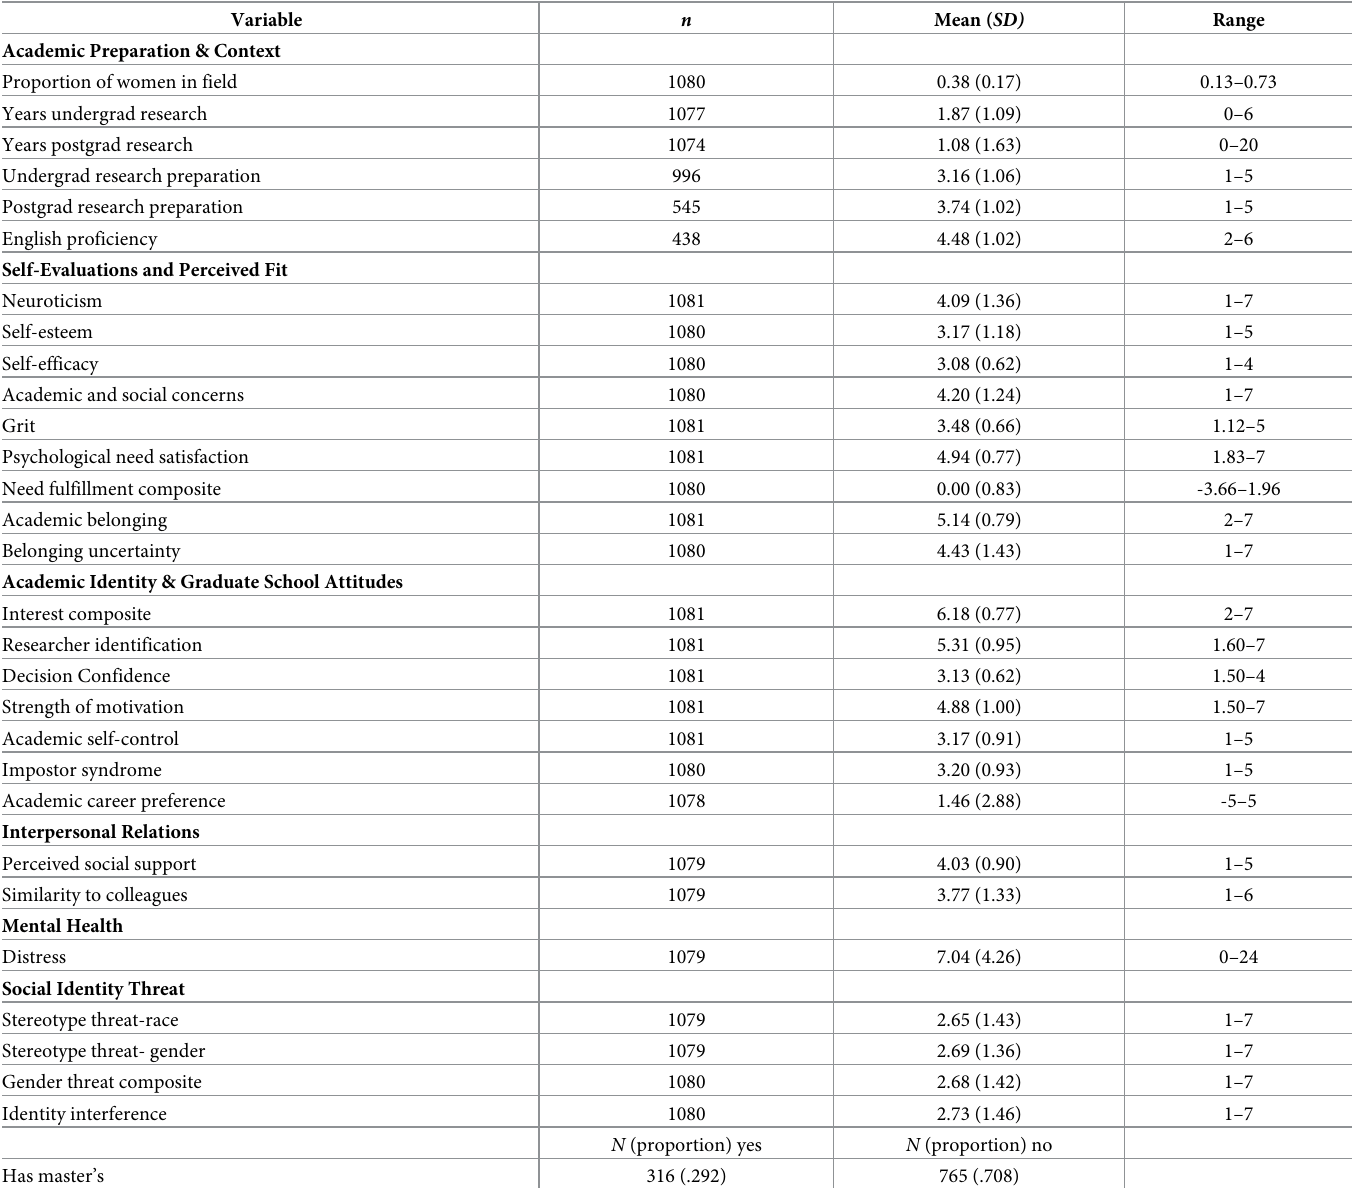
Table 2. Descriptive statistics on proximal